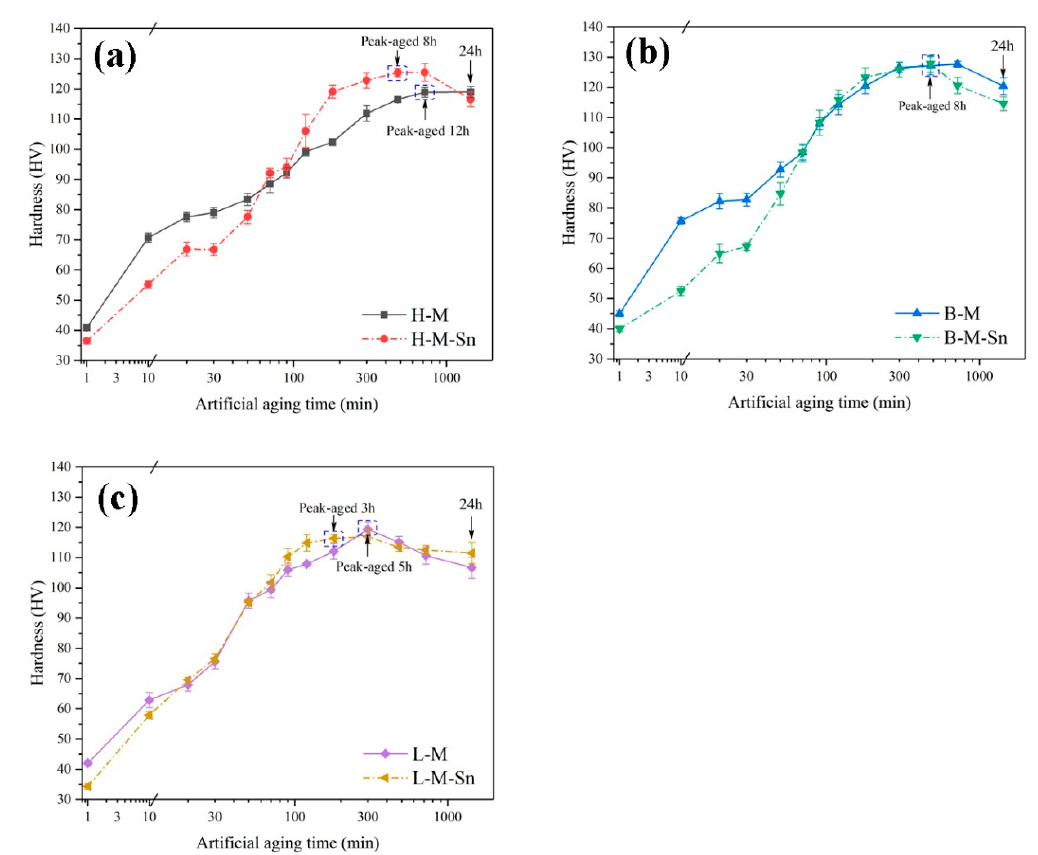
Figure 1. Evolution of hardness during artificial ageing at 180 °C for the investigated alloys: ( a ) H–M